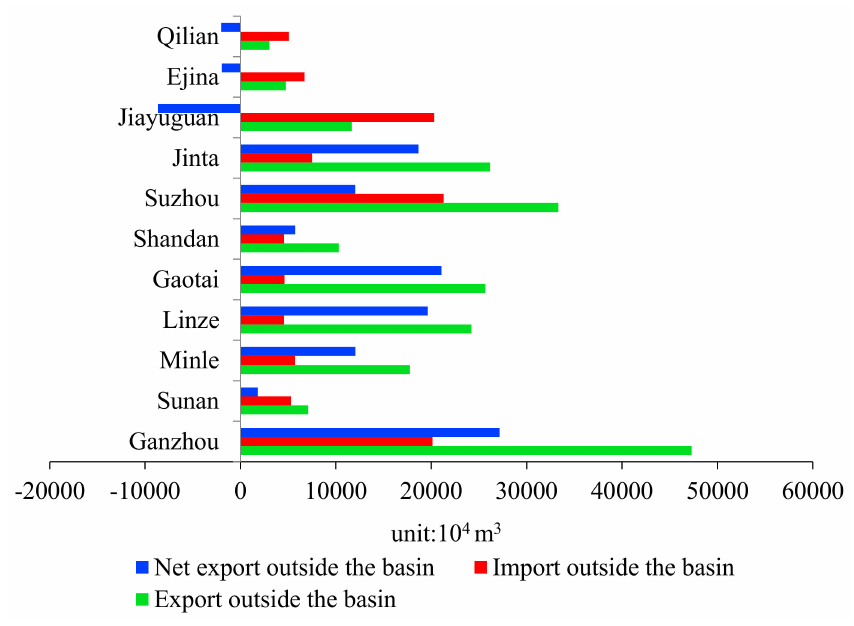
Figure 3. Virtual water flows between different counties in the Heihe River Basin. Table 3. Socio-economic characteristics of the Heihe River